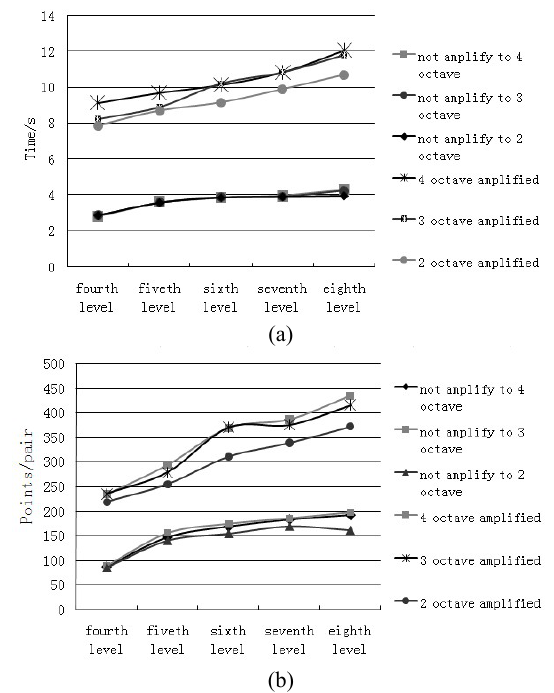
Figure 1. (a) Contrast the operation time of different SIFT Operators, (b) Contrast numbers of feature points of different SIFT